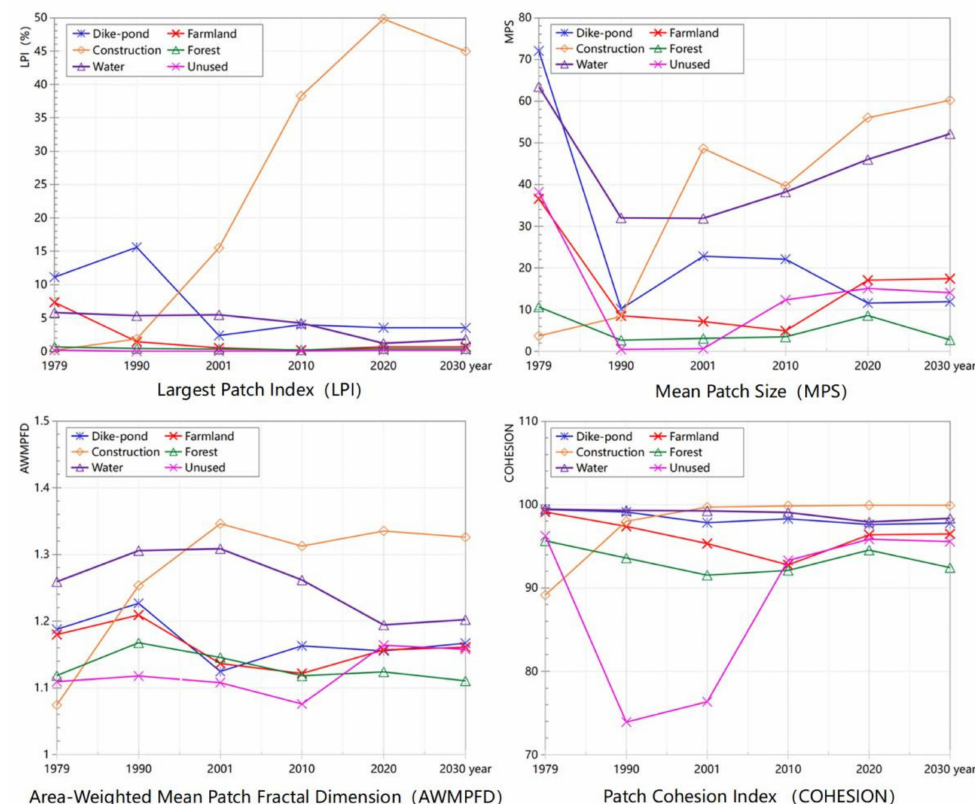
Figure 6. Spatial metric evolution at the class scale from 1979 to